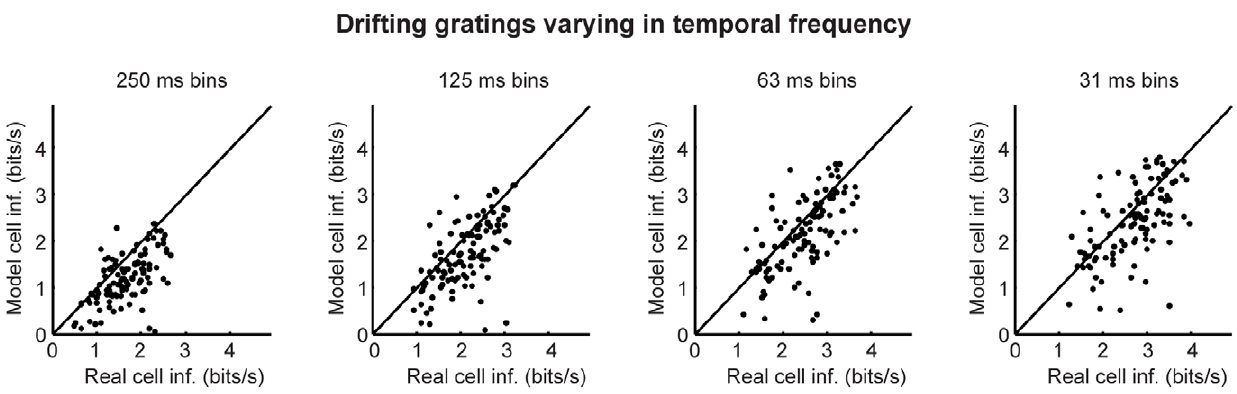
Figure 1. The amount of information carried by the model cells closely matched that of their real cell counterparts, when the stimulus set consisted of drifting gratings that varied in temporal frequency. The mutual information between each model cell’s responses and the stimuli was calculated and plotted against the mutual information between its corresponding real cell’s responses and the stimuli. Bin sizes ranged from 250 ms to 31 ms; n =109 cells; stimulus entropy was 4.9 bits (30 one-second movie snippets). Note that there is scatter both above and below the line because of data limitation.